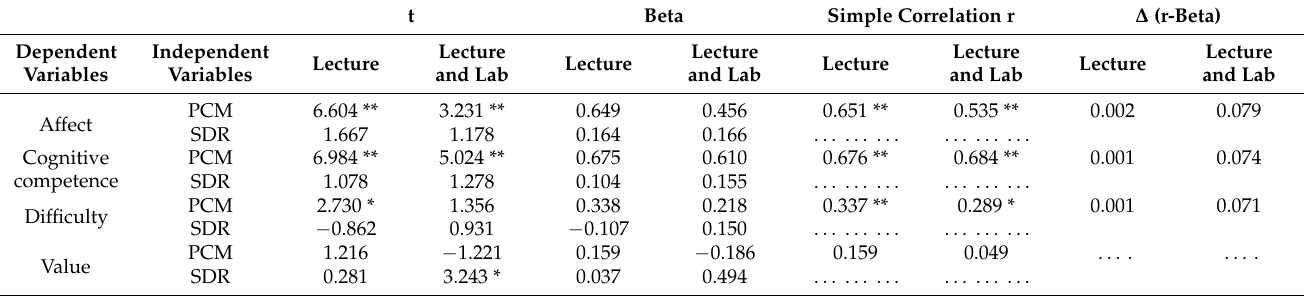
Table 3. Beta and product–moment correlation coefficients among variables in the two